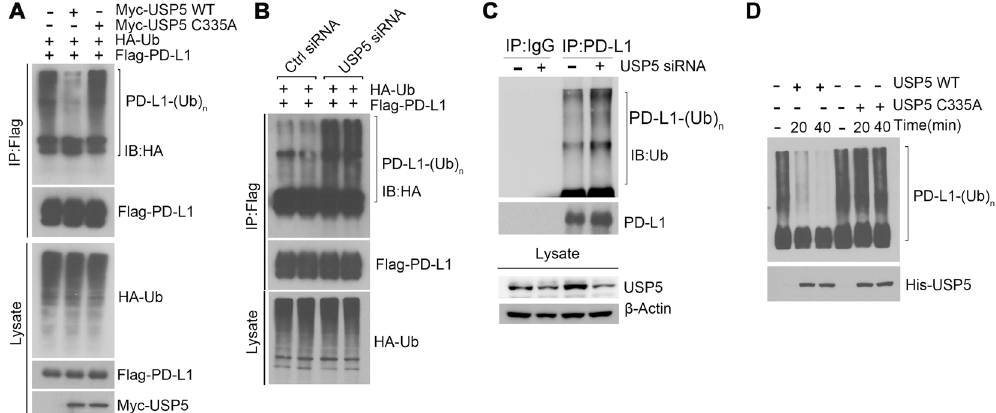
Fig. 3 USP5 deubiquitinates PD-L1. A Immunoprecipitates and western blot analysis of cell lysates derived from H1299 cells transfected with HA-Ub, Flag-PD-L1, Myc-USP5 WT/C335A and treated with 5 µM MG132 for 6 h. B H1299 cells with or without USP5 knockdown by siRNA were co-transfected with HA-Ub and Flag-PD-L1, immunoprecipitation was performed using anti-FLAG af fi nity beads after 5 µM MG132 treatment for 6 h. Poly-ubiquitination of PD-L1 was analyzed by western blot with anti-HA antibodies. C H1299 cells were transfected with or without USP5 siRNA, 72 h after transfection, cells were lysed and subjected to anti-PD-L1 immunoprecipitation (IP), followed by analysis of PD-L1 ubiquitination using immunoblotting with anti-Ub(ubiquitin) antibody. D USP5 deubiquitinates polyubiquitination of PD-L1 in vitro. Flag-PD- L1 and HA-Ub were transfected in HEK293T cells. Poly-ubiquitinated PD-L1 was then immunoprecipitated with anti-Flag M2 beads and incubated with puri fi ed USP5-WT/C335A protein as indicated time. Lysates were analyzed by IB with indicated antibodies.